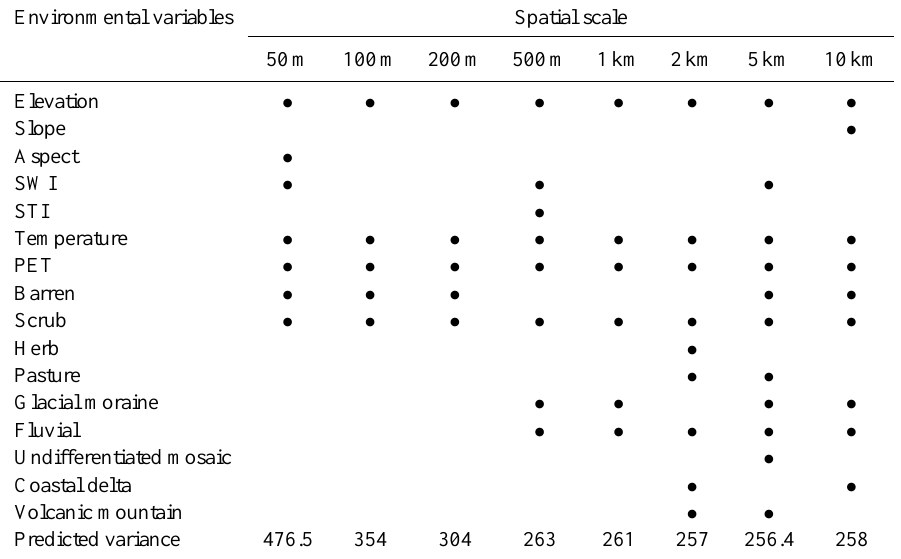
Table 1. Environmental predictors and predicted variance of soil organic carbon stocks across different spatial scales. Black dots represent statistically significant ( P <0.05)